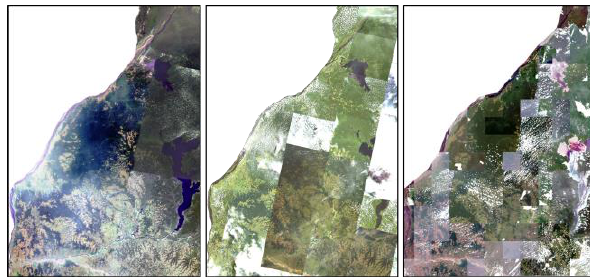
Figure 2: (left) 2001 Landsat mosaic. (middle) ALOS Avnir-2 mosaic (2010) and (right) RapidEye mosaic